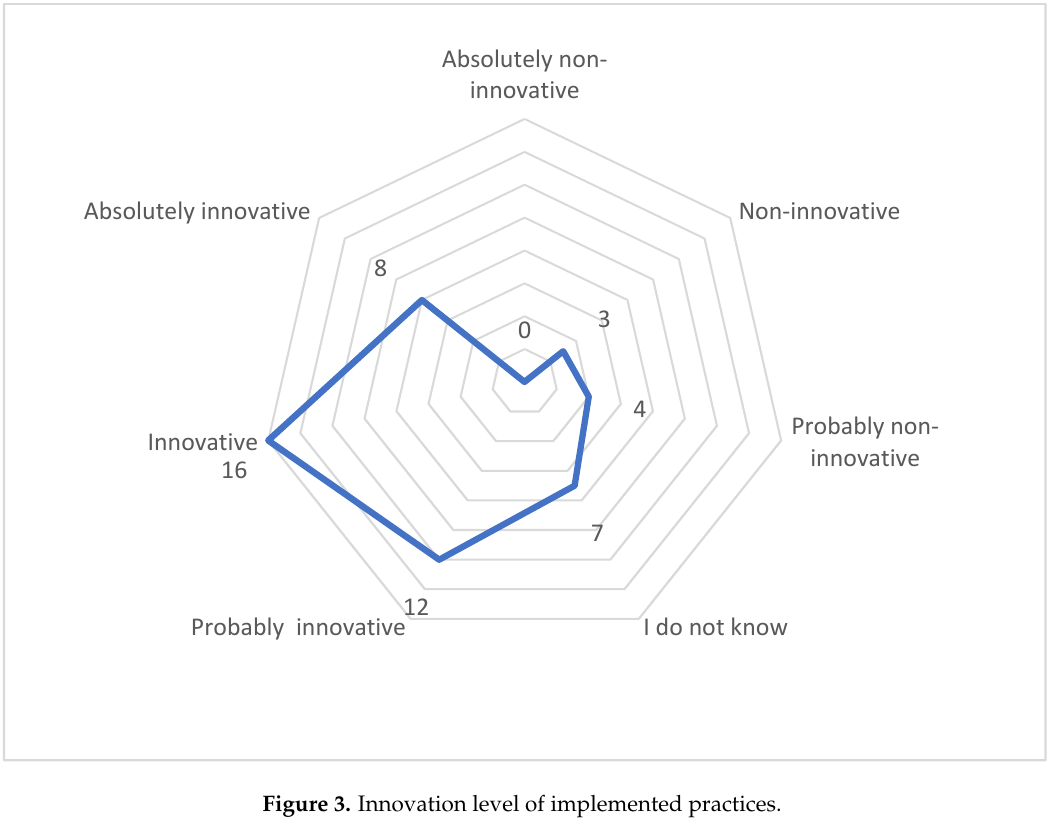
Figure 3. Innovation level of implemented practices.